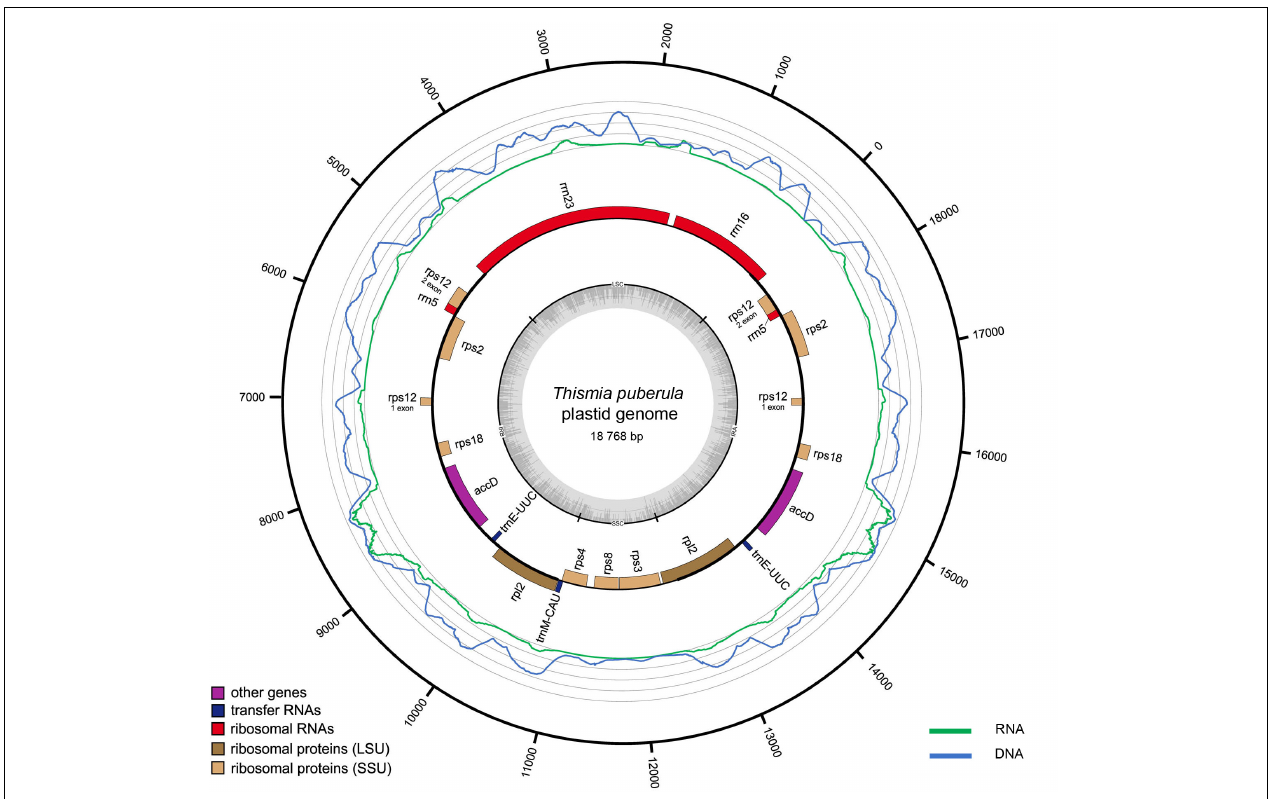
FIGURE 1 | Plastid genome of Thismia puberula , its GC-content, gene expression and coverage by genomic DNA sequencing reads. This species has the largest gene set and was available as a living plant allowing to analyze the transcriptome. Dark gray dashes denote GC content; thick black lines denote IR and thinner lines denote single copy regions. Genes shown outside of the circle are transcribed counterclockwise and those inside are transcribed clockwise. Green and blue lines show coverage by transcriptome reads and genomic DNA reads. Gray circles correspond to a 1000x coverage for transcriptome and 2000x for DNA.